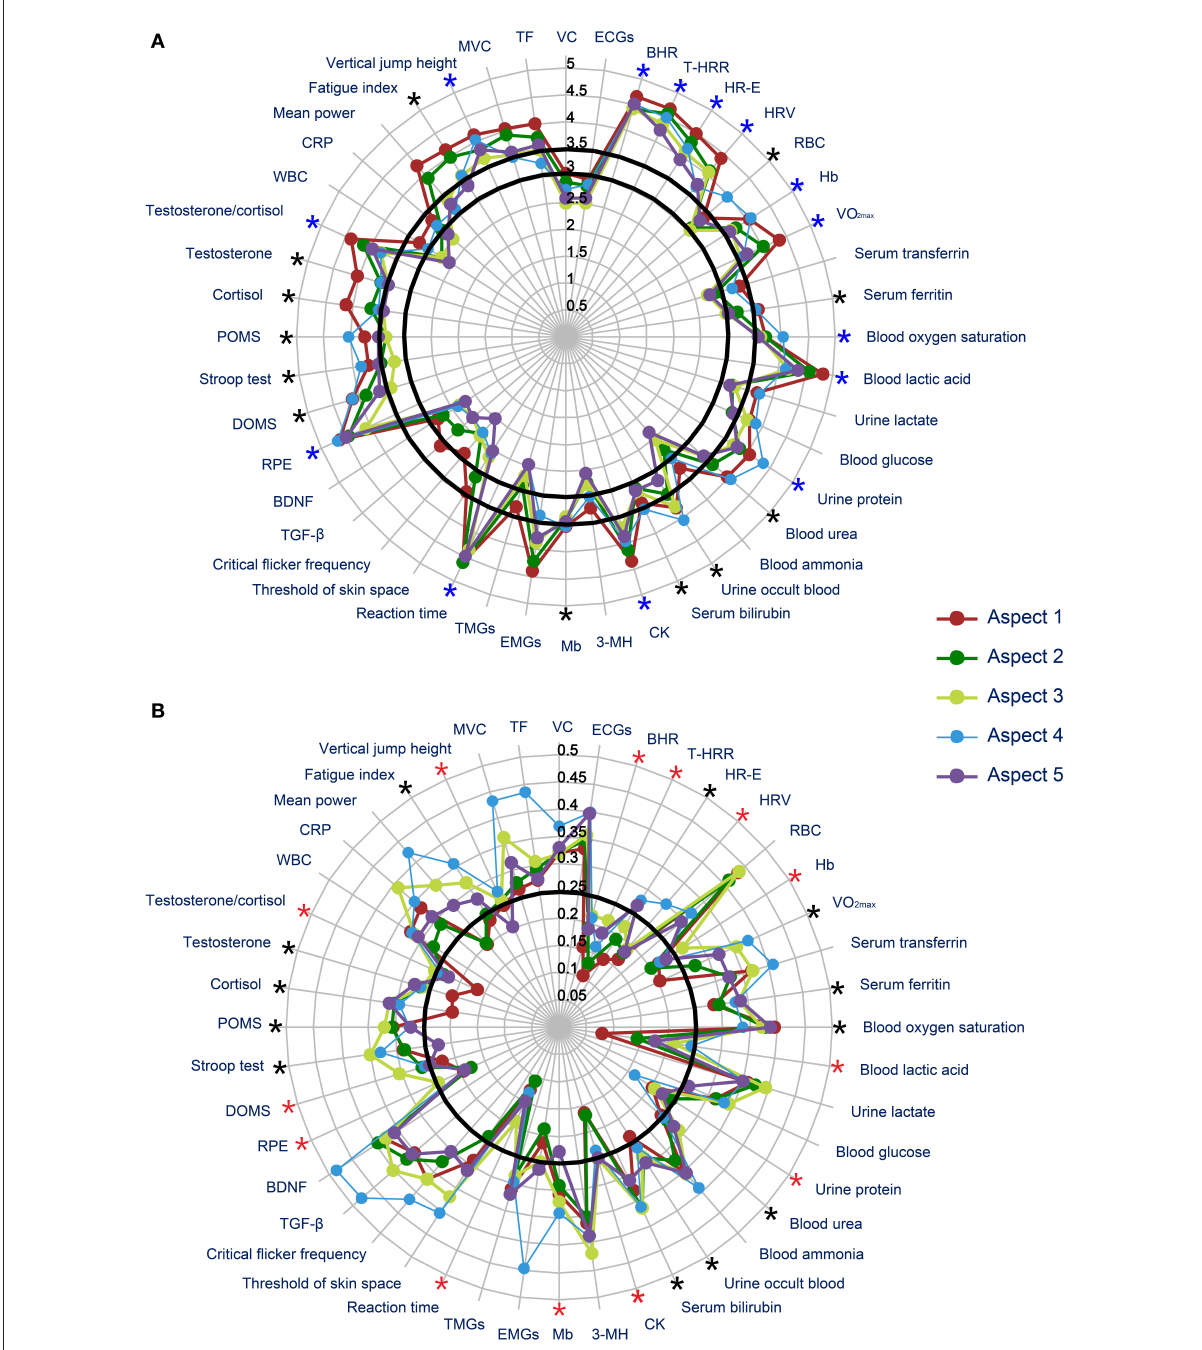
FIGURE3 Results of round 3. (A) Mean score of each indicator in round 3; (B) coefficient of variation of each indicator in round 3. *in black color: indicators with mean scores of aspects 1, 2, 3 and 5 of ≥ 3.0 and that of aspect 4 of ≥ 3.5; *in blue color: indicators with mean scores of aspects 1–5 of ≥ 3.5; *in red color: indicators with CVs of aspect 5 of ≤ 0.25. VC, vital capacity; ECGs, electrocardiogram parameters; BHR, basic heart rate; T-HRR, heart-rate recovery time; HR-E, heart rate during exercise; HRV, heart rate variability; RBC, red blood cell count; Hb, hemoglobin; VO 2max , maximum oxygen intake; CK, creatine kinase; 3-MH, urea 3-methylhistidine; Mb, serum myoglobin; EMGs, electromyogram parameters; TMGs, tensiomyography parameters; TGF- β , transform growth factor- β ; BDNF, brain-derived neurotrophic factor; RPE, Borg’s Rating of Perceived Exertion Scale; DOMS, delayed onset muscle soreness; POMS, Profile of Mood State Questionnaire; WBC, white blood cell count; CRP, C-reactive protein; MVC, maximum voluntary contraction; TF, twitch